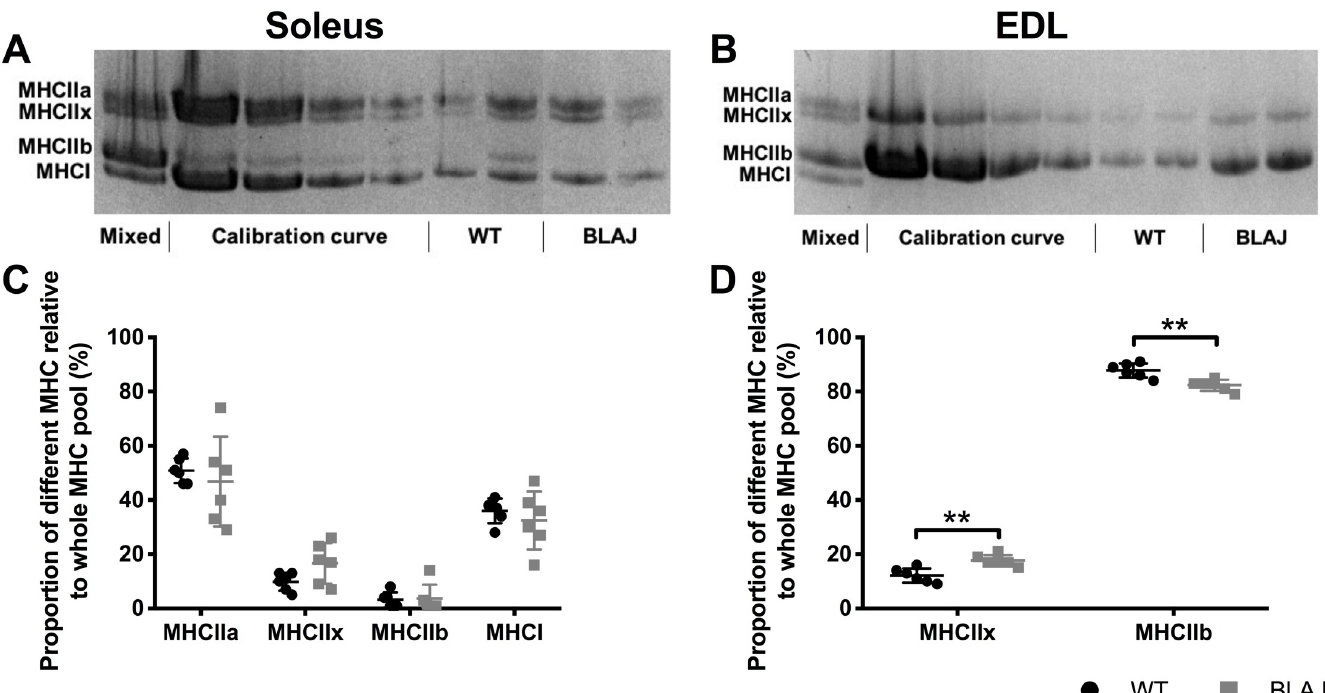
Fig 7. Myofibre myosin heavy chain (MHC) composition of soleus and EDL muscle from WT and BLAJ mice aged 10 months ( n = 6). Representative MHC gels (A, B) for soleus and EDL muscles, loaded with a pooled sample (Mixed) used to generate the Calibration curve (see Methods), with (C, D) showing percentage of different MHC in soleus and EDL muscles. �� BLAJ significantly different to WT ( p s < 0.01). Data are presented as individual values with horizontal lines indicating mean ± SD.